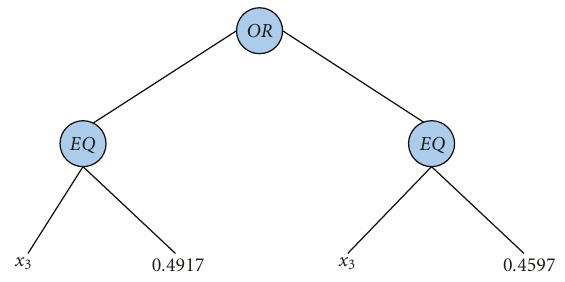
Figure 4: The primary mask Δ (cid:13) H (9) presented in a form of the syntax